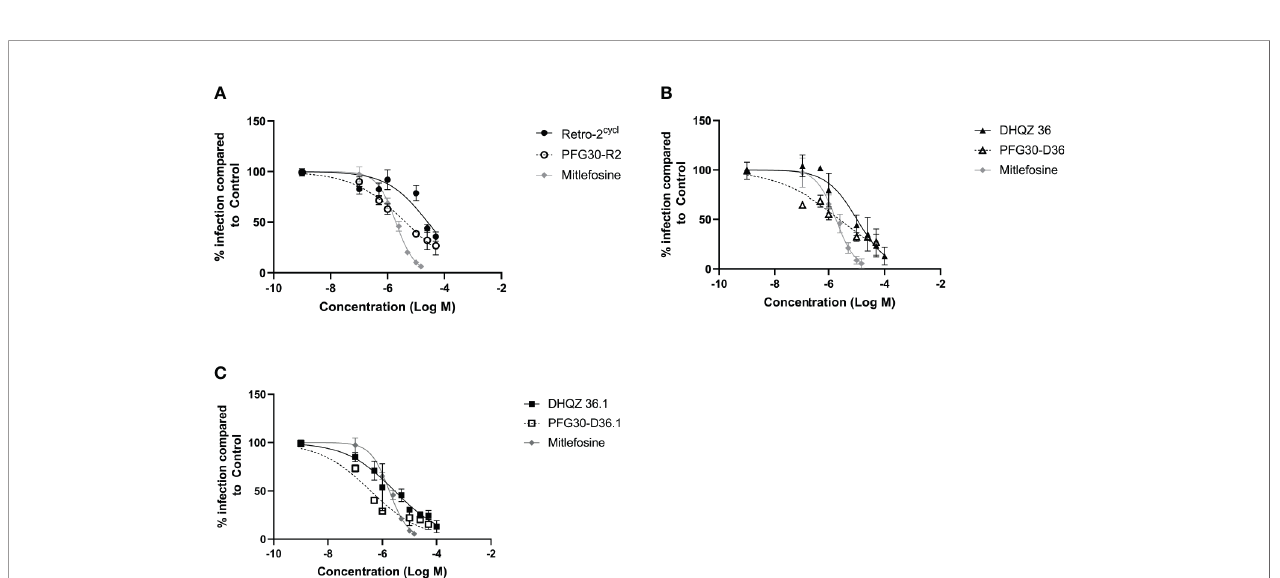
FIGURE 3 | Evaluation of polymer-encapsulated compounds on L. donovani -infected RAW264.7 macrophages. L. donovani -infected macrophages were treated for 48 h with the following compounds: (A) free Retro-2 or PFG30 + Retro-2 (PFG30-R2); (B) free DHQZ 36 or PFG30 + DHQZ 36 (PFG30-D36); (C) free DHQZ 36.1 or PFG30 + DHQZ 36.1 (PFG30-D36.1) at concentrations ranging from 100 nM to 100 m M. Miltefosine (100 nM to 15 m M) treatment was used as a positive control for parasite clearance. Cells were fi xed in 2% PFA in PBS. IFAs were performed for detection of LAMP-1 and cell and parasite nuclei with DAPI. At least 200 cells were scored per coverslip and infection rates were standardized to a vehicle control before EC 50 estimation. Data were compiled from at least three biological repeats.